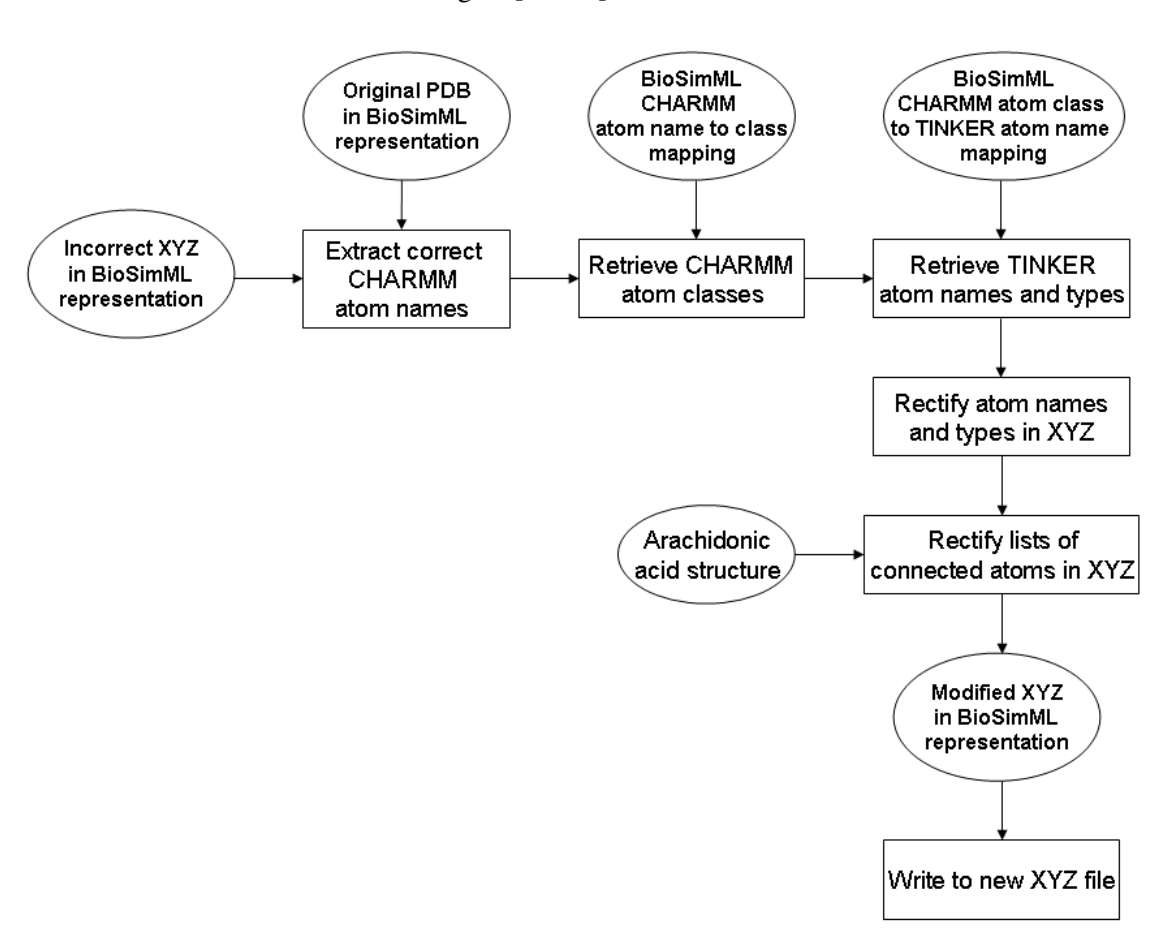
Figure 7: The workflow for correcting the XYZ